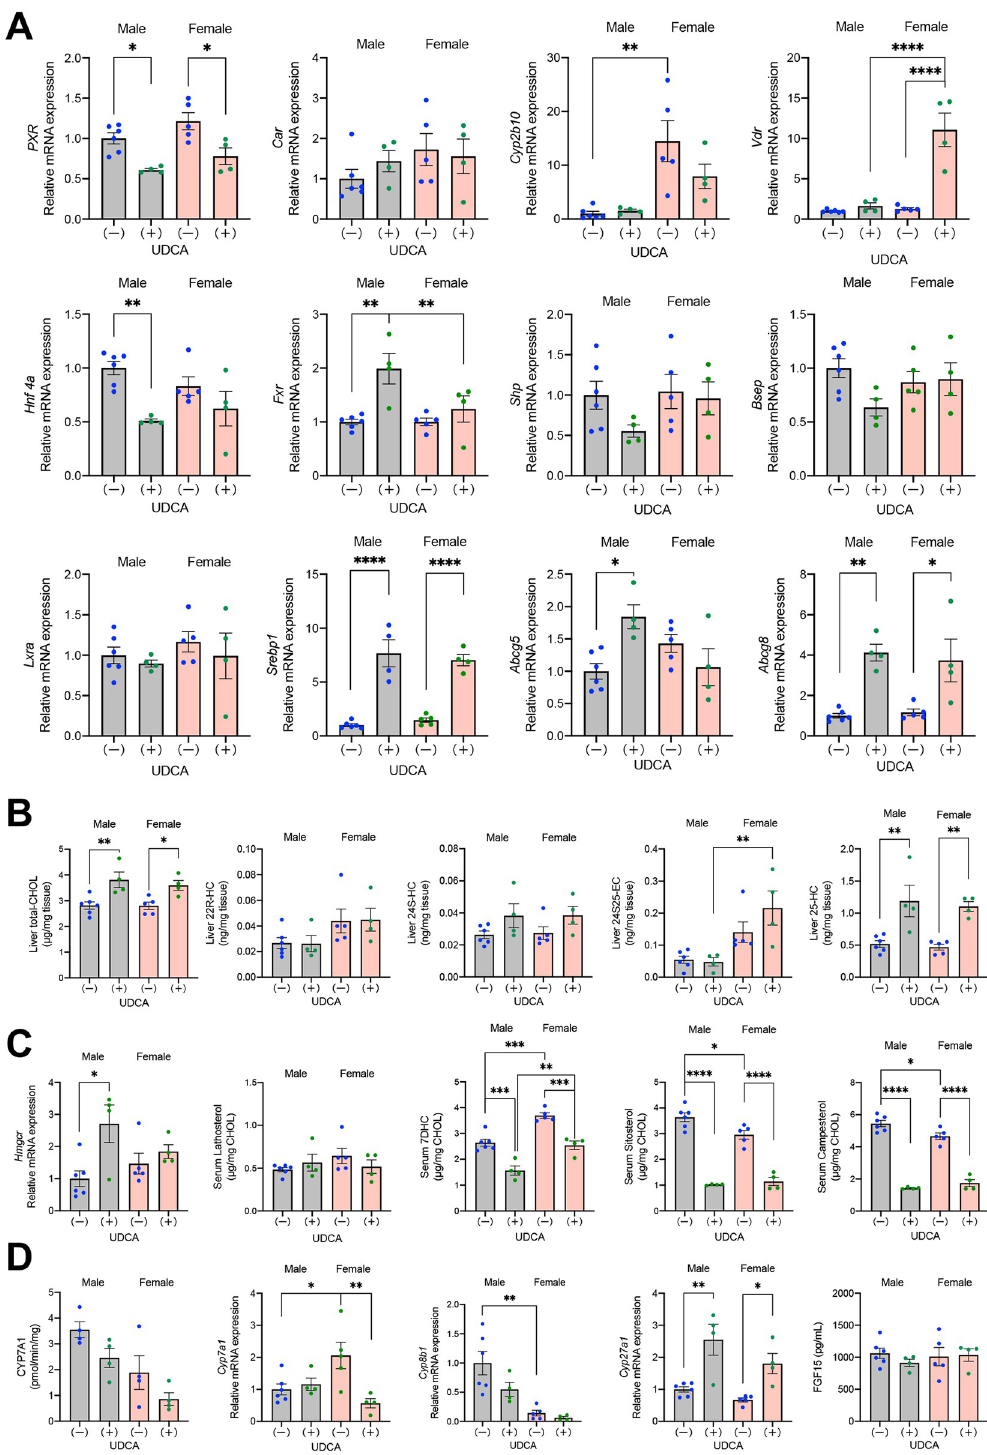
Fig 6. Effects of UDCA treatment on hepatic cholesterol and BA metabolism. DKO mice at 20 weeks of age, with (+) or without (-) UDCA treatment were compared. (A) Hepatic mRNA expression levels of nuclear receptors and their target genes. (B) Hepatic concentrations of cholesterol and oxysterols. CHOL, cholesterol; HC, hydroxycholesterol; EC, epoxycholesterol. (C) Hepatic mRNA expression levels of the key enzyme in the cholesterol biosynthetic pathway and serum sterol concentrations associated with cholesterol metabolism. (D) Hepatic activities and mRNA expression levels of key